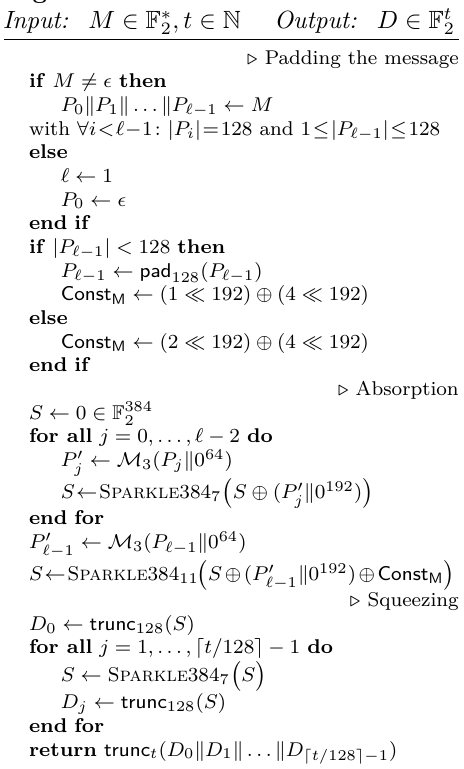
Algorithm 4 Esch 256 Algorithm 5 XOEsch